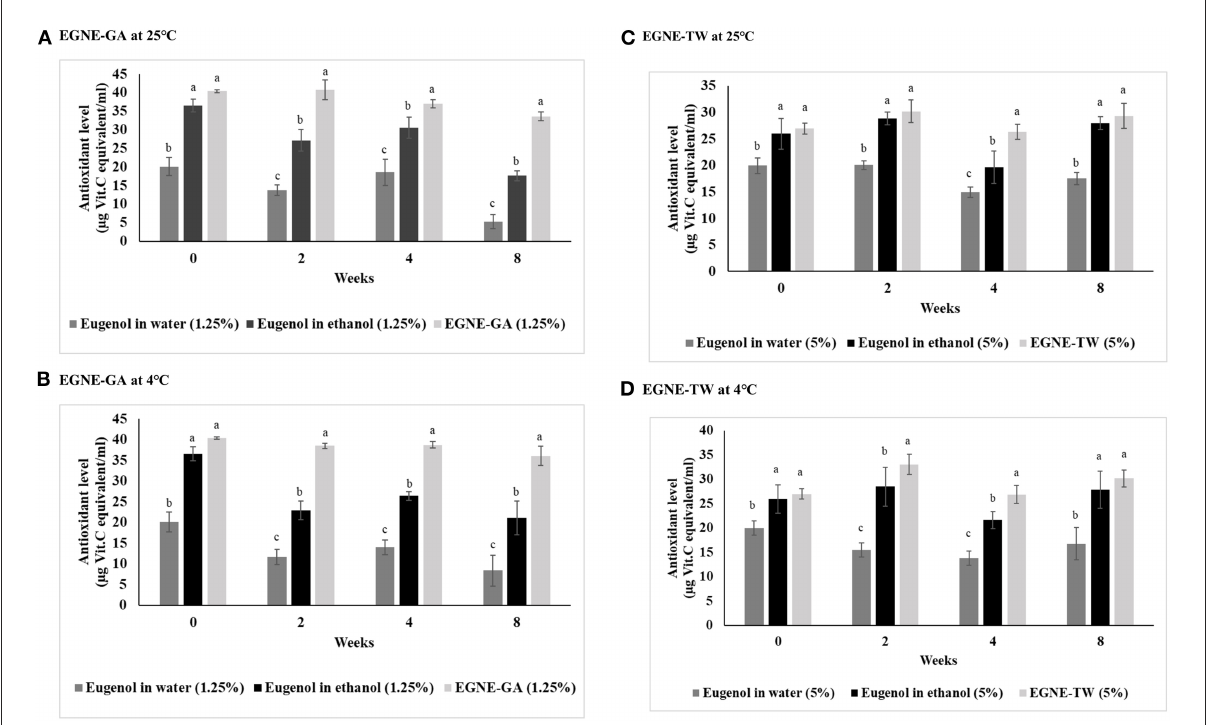
FIGURE1 Antioxidant activity (ug Vit. C equivalent/ml) of eugenol in water, eugenol in ethanol, EGNE-GA, and EGNE-TW stored at 25 (A,C) or 4 ◦ C (B,D) for a period of 8 weeks. The error bar represents mean ± SE. a − c superscripts represents significance difference between each treatment within each time point. Error bar represents SEM ( n =